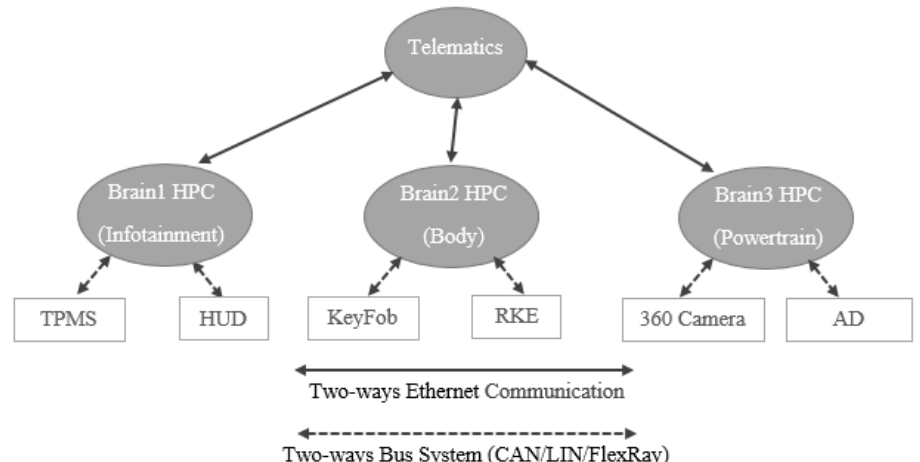
Figure 17. Use Case Representation of Three-Brain